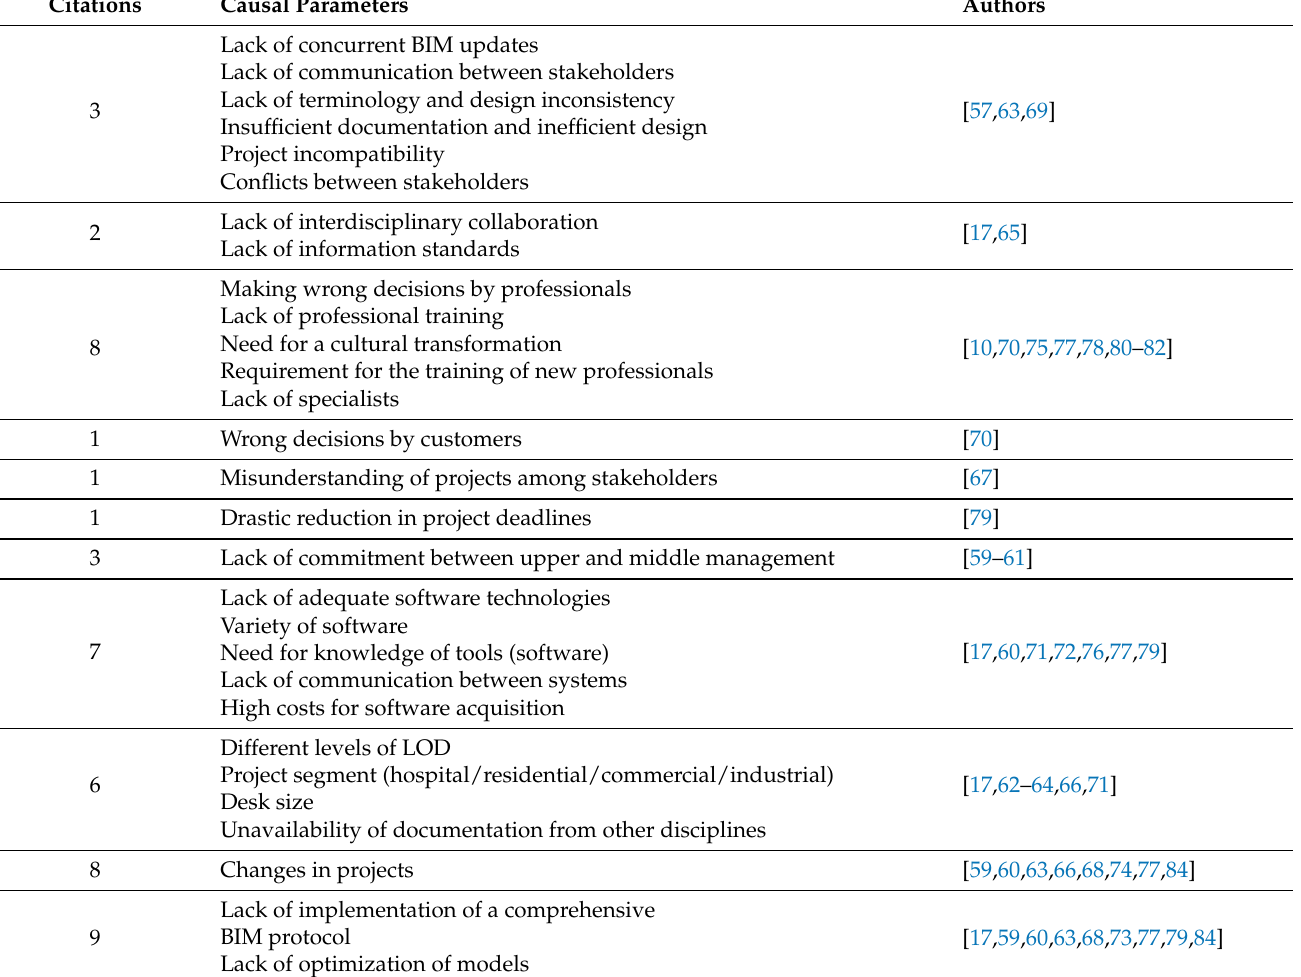
Table A1. Theoretical framework of causal